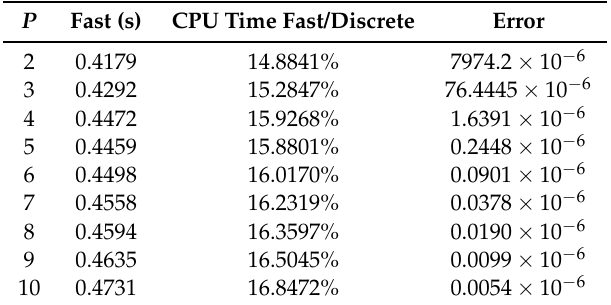
Table 1. Error and CPU time evolution for the all-metallic filter ( R = 4 cavities) as the number of frequency points for the fast sweep ( P ) increases. Discrete sweep used 500 points and took 2.808 s.